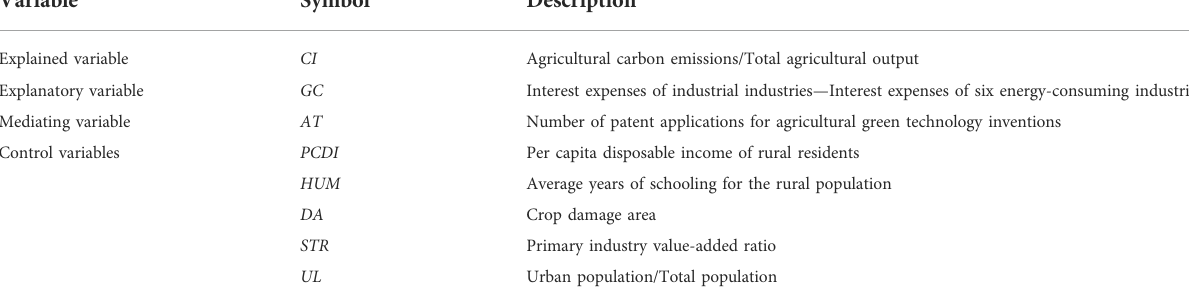
TABLE 2 Variable description and explanation.